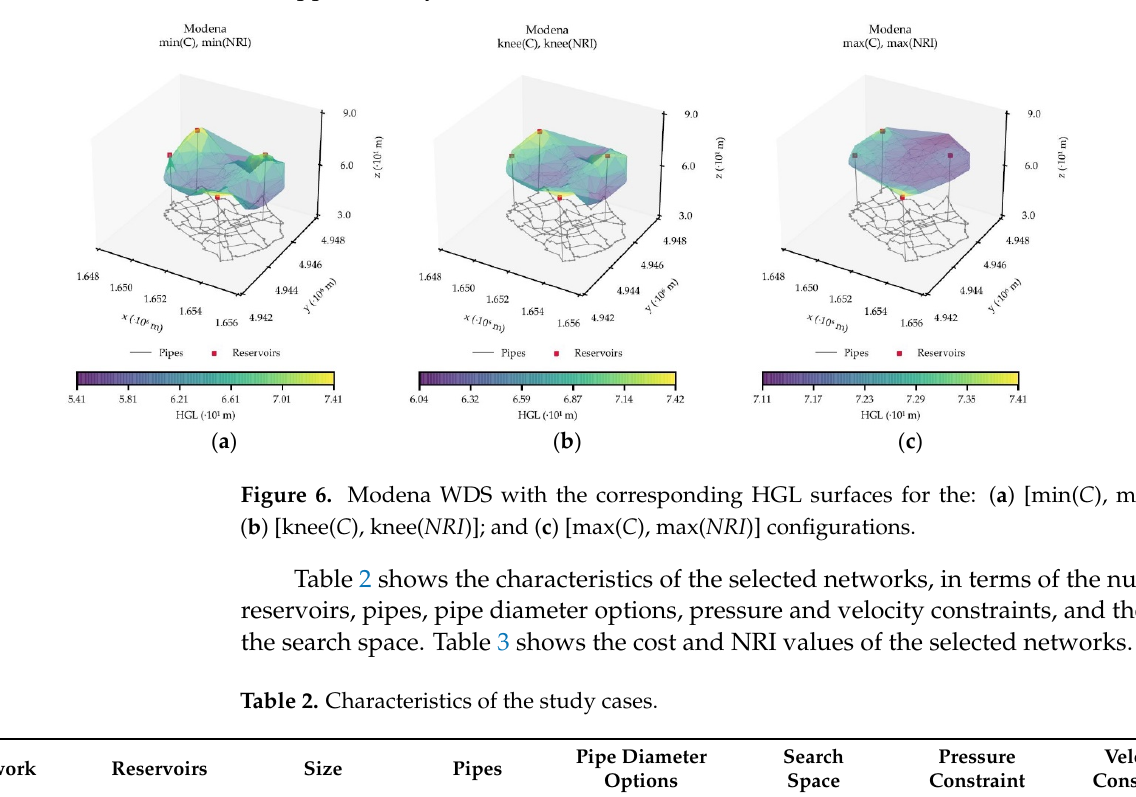
Figure 5. Balerma WDS with the corresponding HGL surfaces for the: ( a ) [min(C), min(NRI)]; ( b ) [knee(C), knee(NRI)]; and ( c ) [max(C), max(NRI)] configurations.